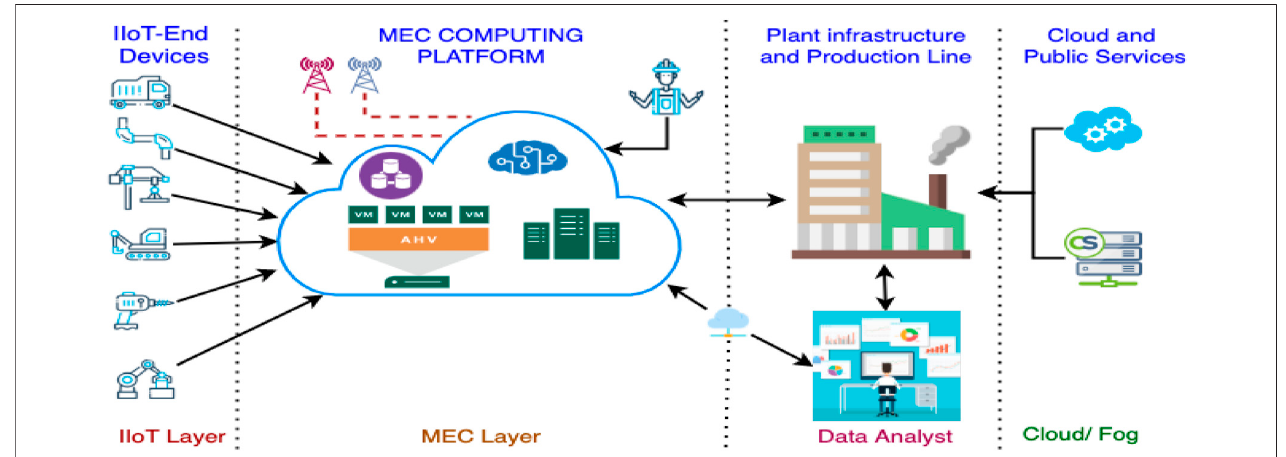
FIGURE 1 | MEC server connected IIoT